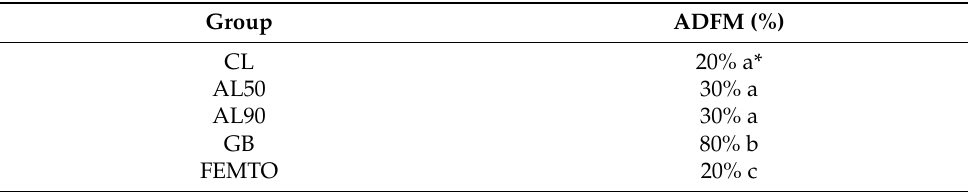
Table 2. Percentages of adhesive-type of failure (ADFM).